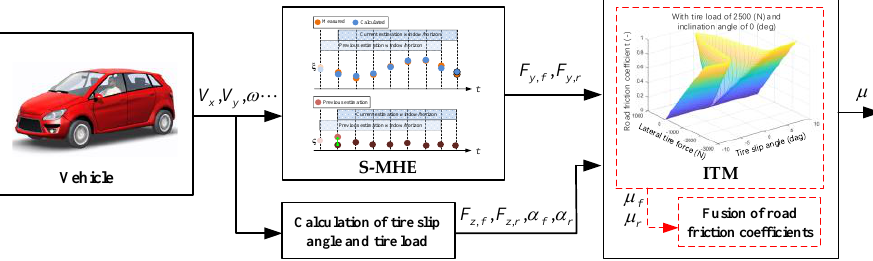
Figure 1. The overall structure of the proposed hierarchical estimation method.